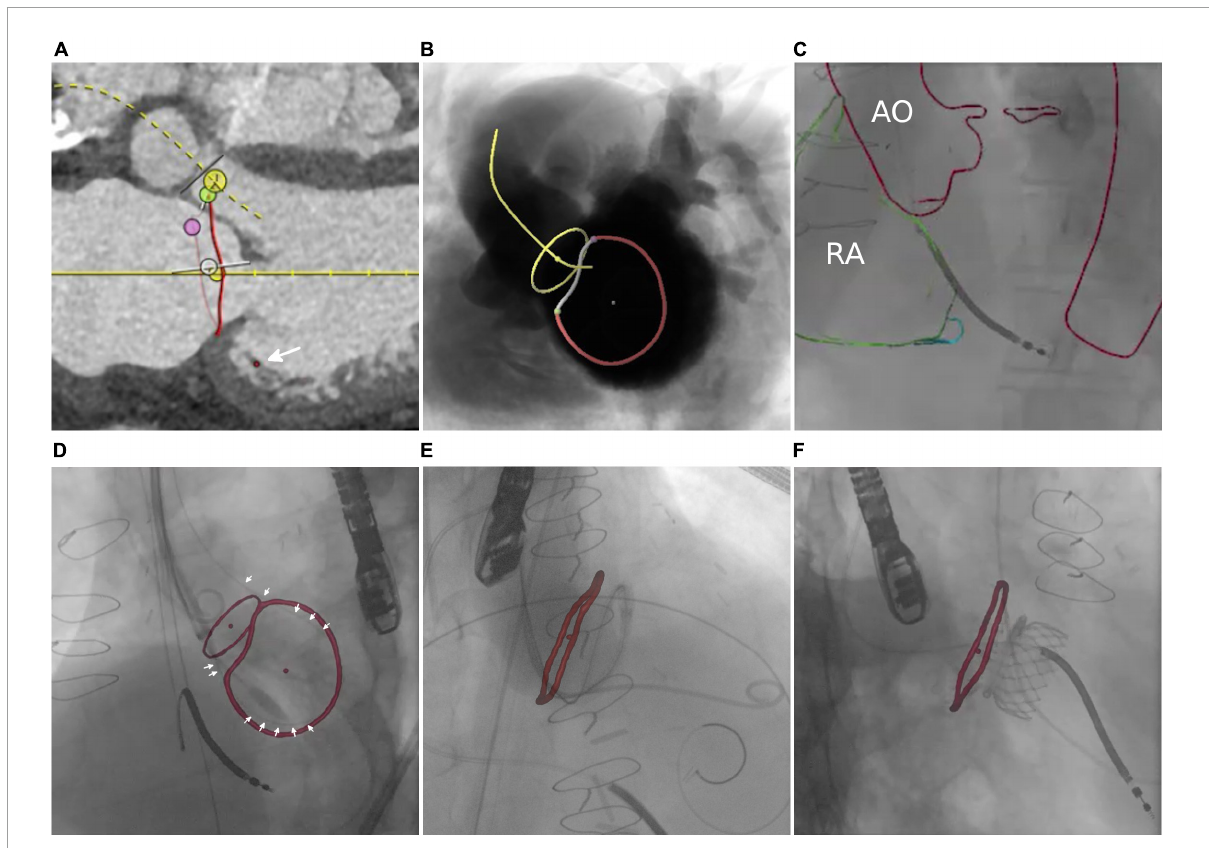
FIGURE4 Transcatheter mitral valve replacement. (A) CTA-based identification of relevant anatomical landmarks, including pronounced trabecularization of subannular left ventricular walls (arrow) bearing the potential for entanglement during subannular looping. Determination of optimal C-arm angulation with panel (B) showing the simulated short-axis view including determined mitral (red) and aortic valve annuli (yellow). (C) Manual registration based on aorta (AO) and right atrium (RA). (D) Image fusion in the short axis view shows the loop placement catheter (white arrows) aligned to the mitral valve annulus. Image fusion in a 4-chamber view indicates the target area and correct positioning of the ring to which the prosthesis is attached (E) and a good correlation between successfully implanted HighLife TM valve after valve implantation (F)